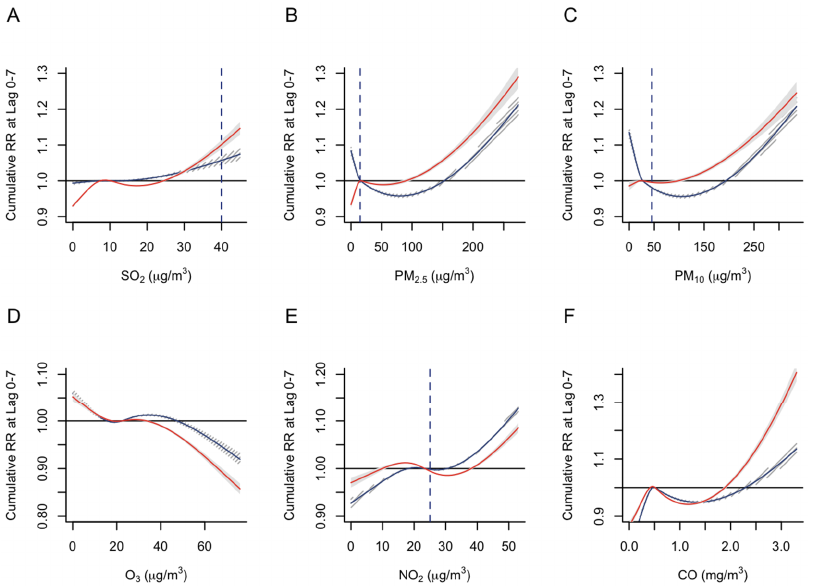
Figure 2. Association between air pollutant levels and cumulative relative risk (RR) of emergency admissions stratified by sex. ( A ) SO 2 levels and RR; ( B ) PM 2.5 levels and RR; ( C ) PM 10 levels and RR; ( D ) O 3 levels and RR; ( E ) NO 2 levels and RR; ( F ) CO levels and RR. The solid blue lines represent the modeled cumulative risk for males, while the solid red lines represent the modeled cumulative risk for females. The shaded areas represent the 95% confidence intervals. The horizontal solid black line represents the null value. The vertical blue dashed line represents the desired air pollutant levels indicated in the WHO air quality guidelines.